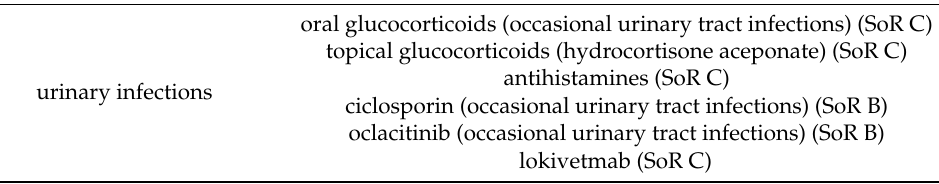
topical glucocorticoids (hydrocortisone aceponate) (SoR